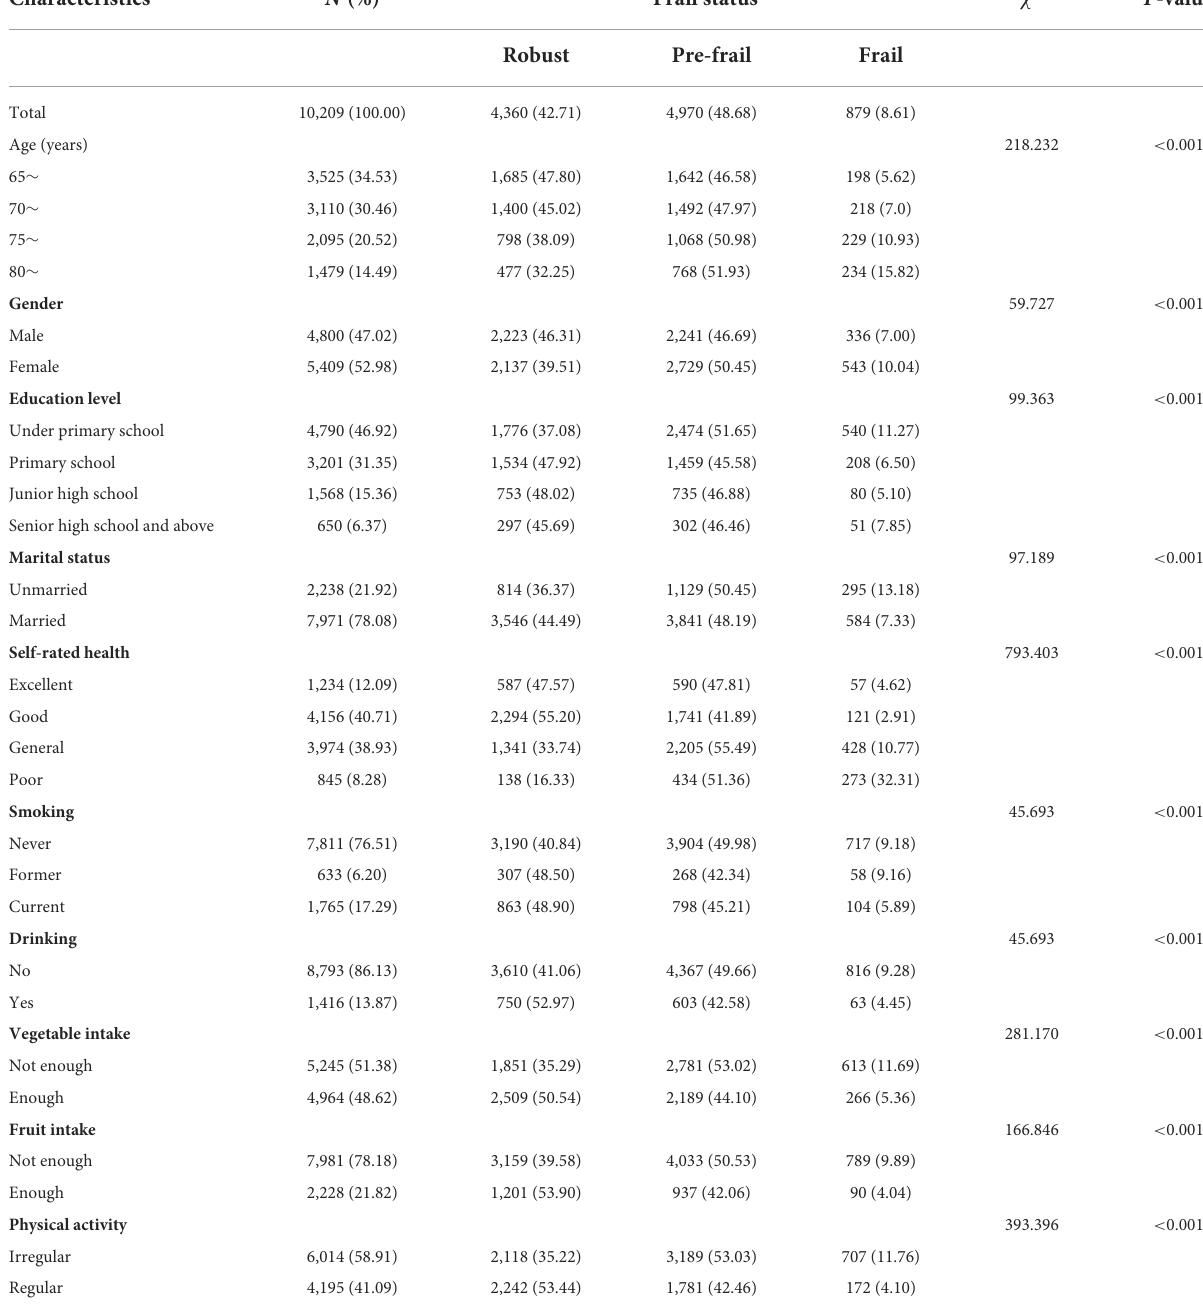
TABLE 1 Characteristics of participants and distribution of frailty ( n , %). Characteristics